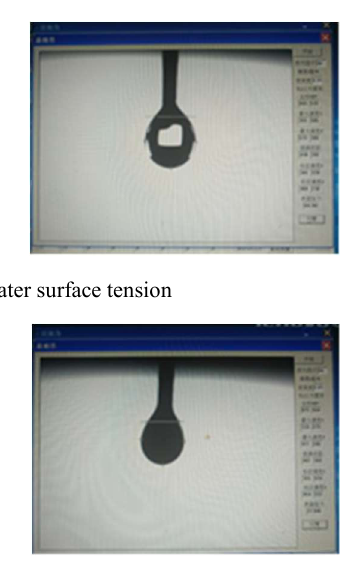
Figure 2. Surface tension of Luliang crude oil